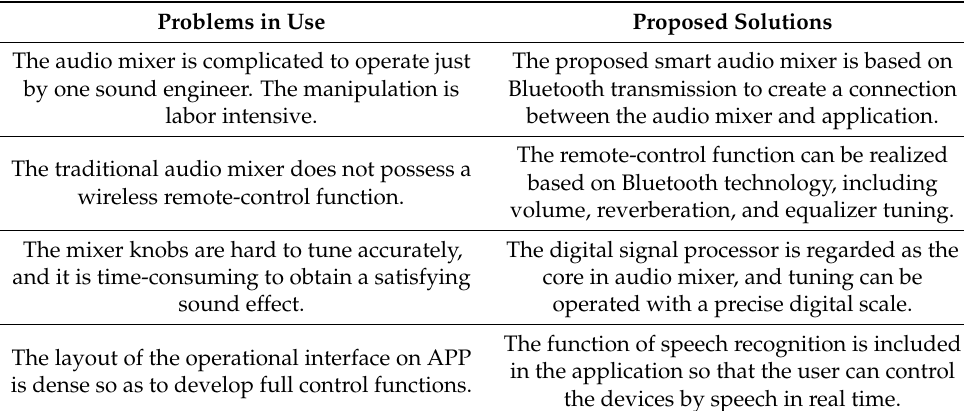
Table 1. Problems of audio mixers and the proposed